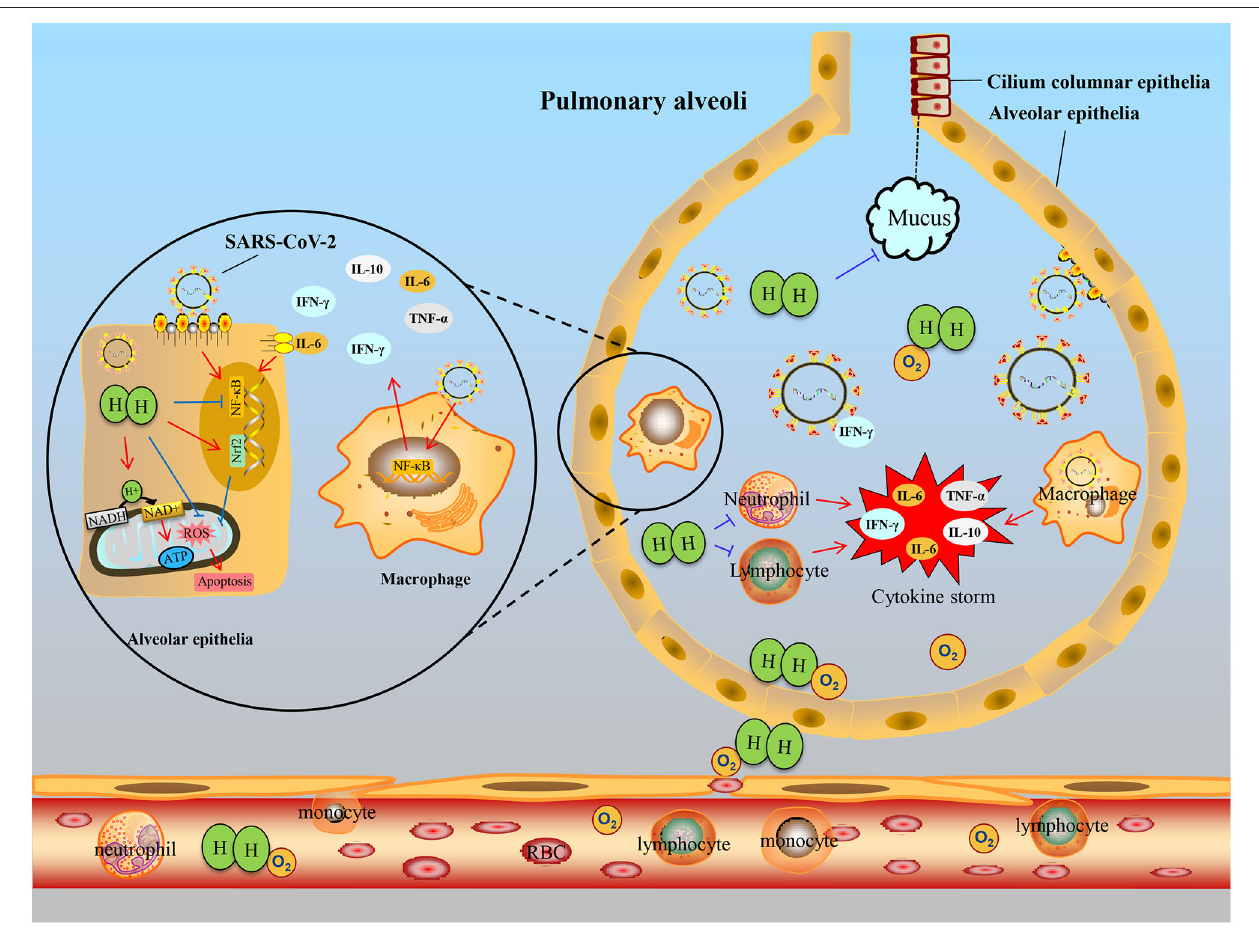
FIGURE 2 | Hypothetical schematic of therapeutic effects of hydrogen for COVID-19. When the SARS-CoV-2 invades the bronchus, the immune defense response is activated, immune cells, such as monocytes and lymphocytes, infiltrate into the alveoli from small vessels, they secrete excessive cytokines IL-6, TNF- α , etc., resulting in cytokine storms and alveolar epithelial cell damage. After hydrogen administration, on the one hand, inflammation can be suppressed by inhibiting NF- κ B transcription to reduce activated immune cells, especially macrophages. On the other hand, hydrogen entering alveolar epithelial cells buffers oxidative stress or regulates Nrf2 transcription and inhibits apoptosis. Furthermore, hydrogen can improve dyspnea by inhibiting the secretion of mucus in bronchiole and assisting oxygen diffusion.